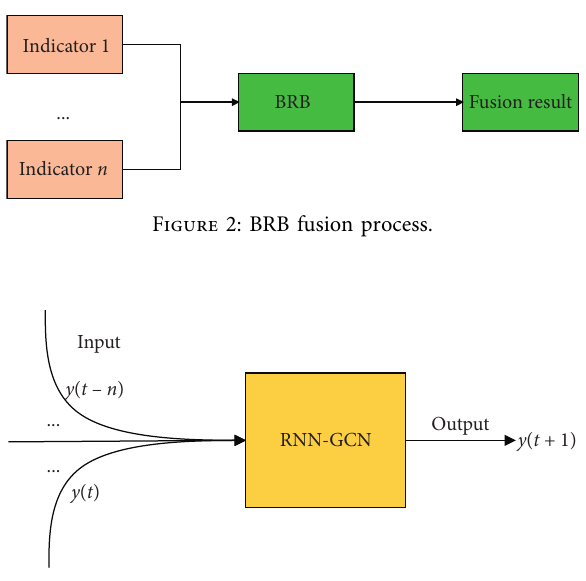
Figure 3: Traffic flow forecasting